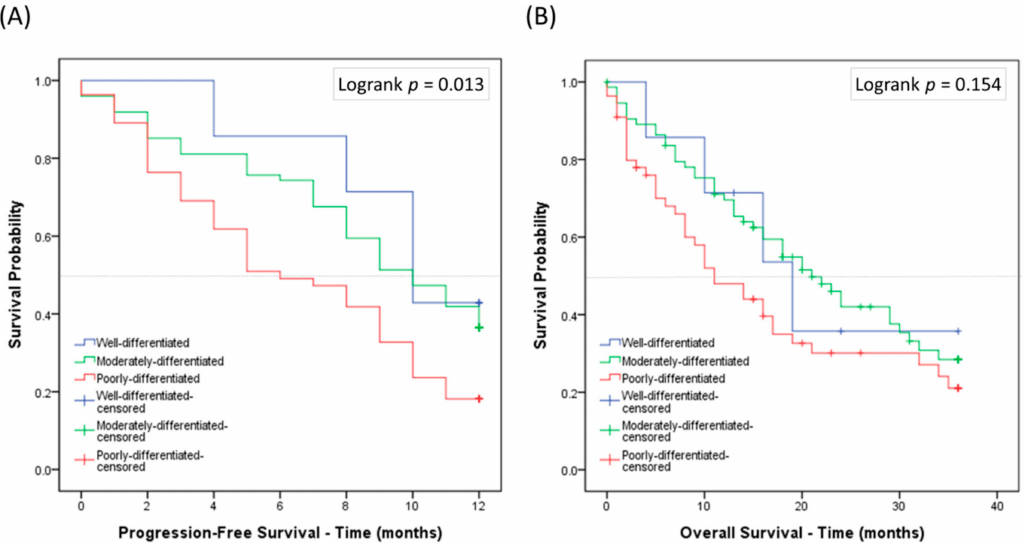
Figure 3. The Kaplan–Meier survival curves for each group of the new grading system: ( A ) progression- free survival; and ( B ) overall